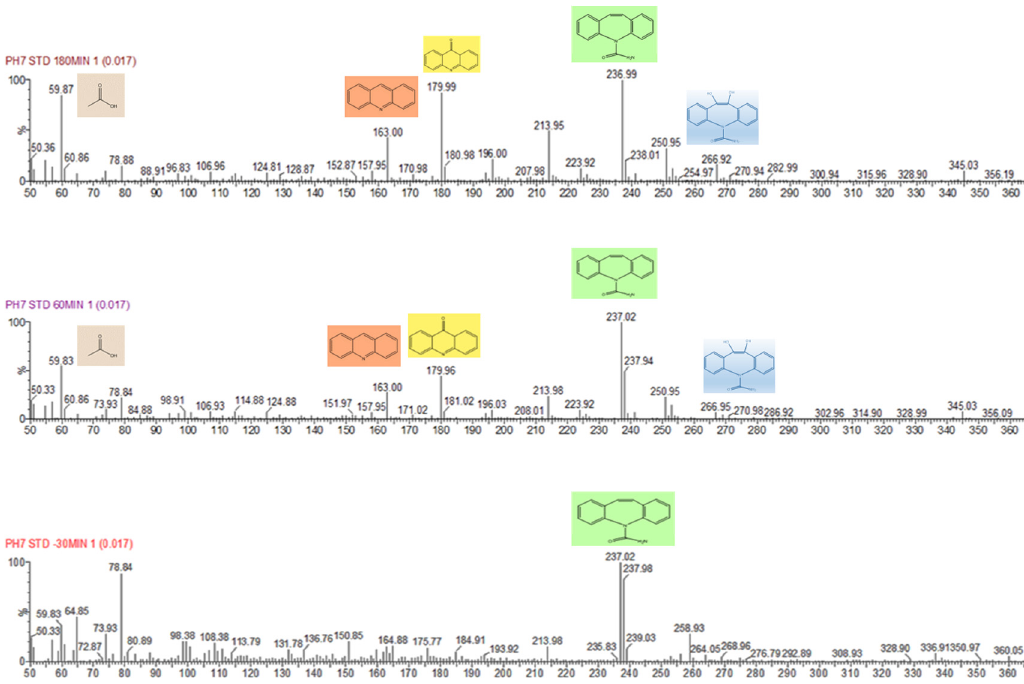
Figure 8. Peaks mass of carbamazepine and some by-products.